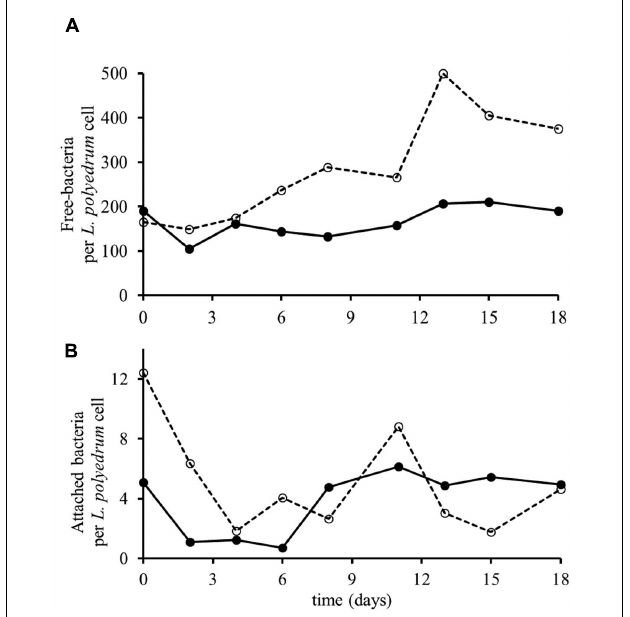
FIGURE 3 | Growth of L. polyedrum and associated bacteria culture under B-s (- -) conditions. (A) Ratio of freely suspended bacteria to L. polyedrum cells. (B) Average number of bacteria attached (cid:32) (cid:35)